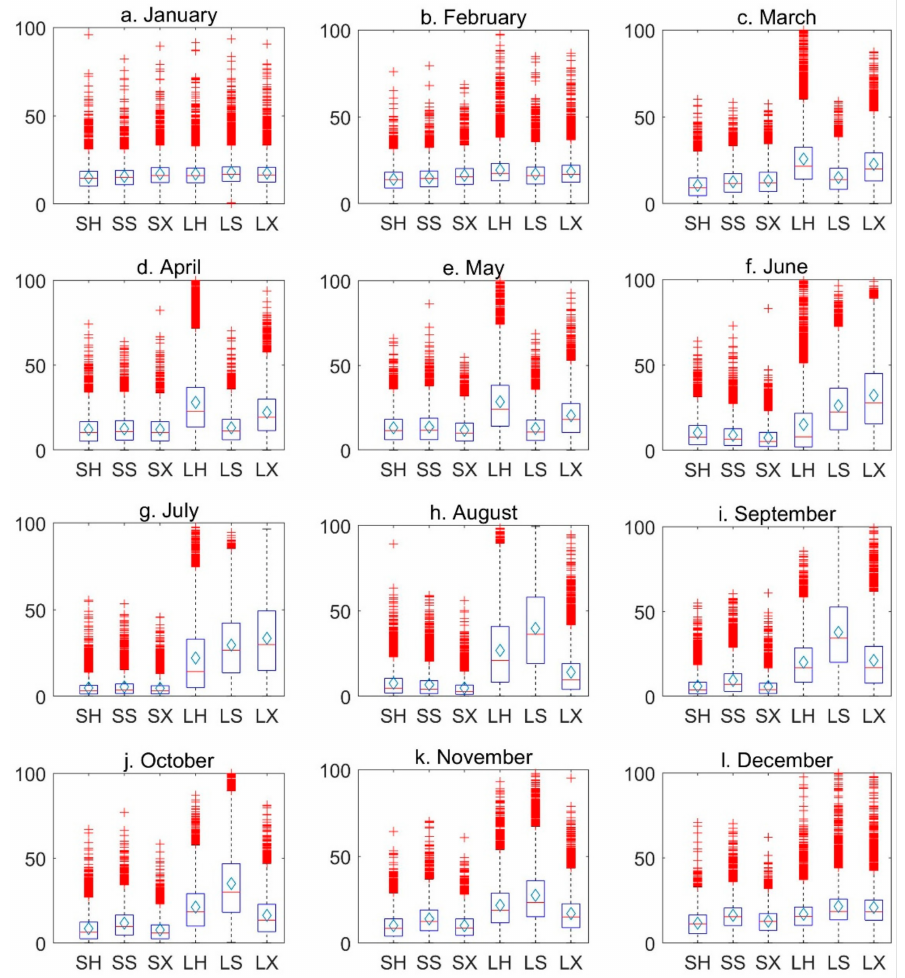
Figure 9. REA weights (%) of the six model-ensemble members in mean monthly runoff projection derived from the posterior distributions of precision parameter. The model-ensemble members are denoted by “SH” (SD-HBV), “SS” (SD-SIMHYD), “SX” (SD-XAJ), “LH” (LW-HBV), “LS” (LW- SIMHYD), and “LX” (LW-XAJ) on the x -axis, respectively. The mean weights of each member are marked by diamonds.